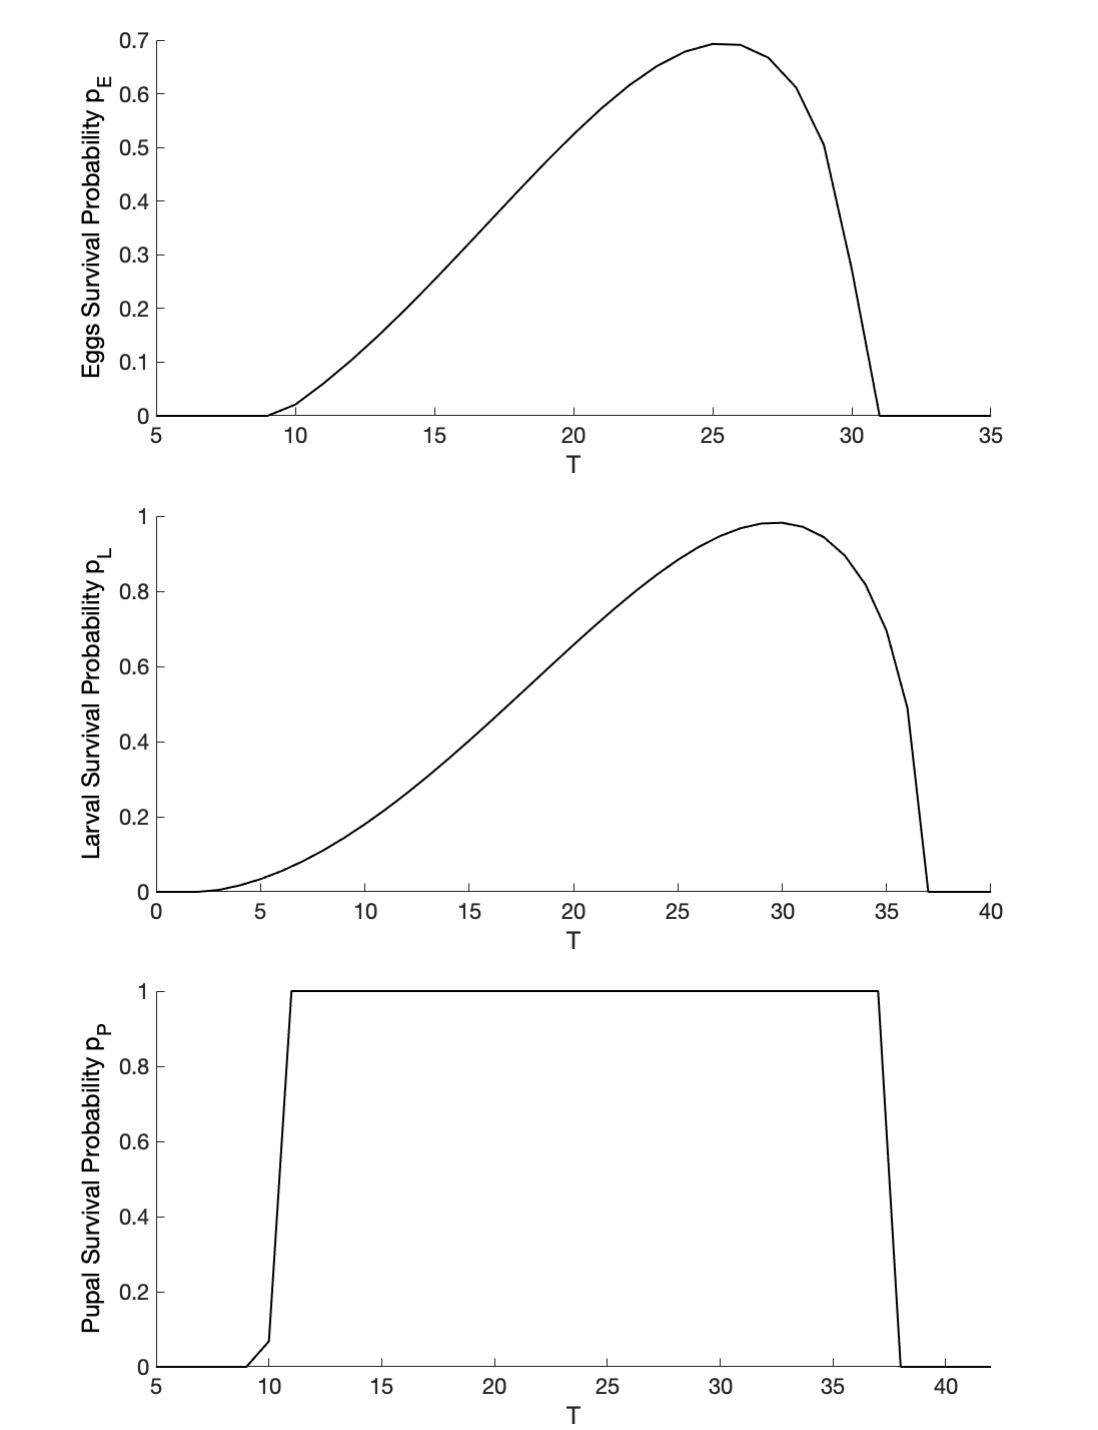
Figure A4. Juvenile stages’ survival probability, eggs p E , larvae p L , and pupae p P as they vary with the temperature range of 0 ◦ C to 50 ◦ C